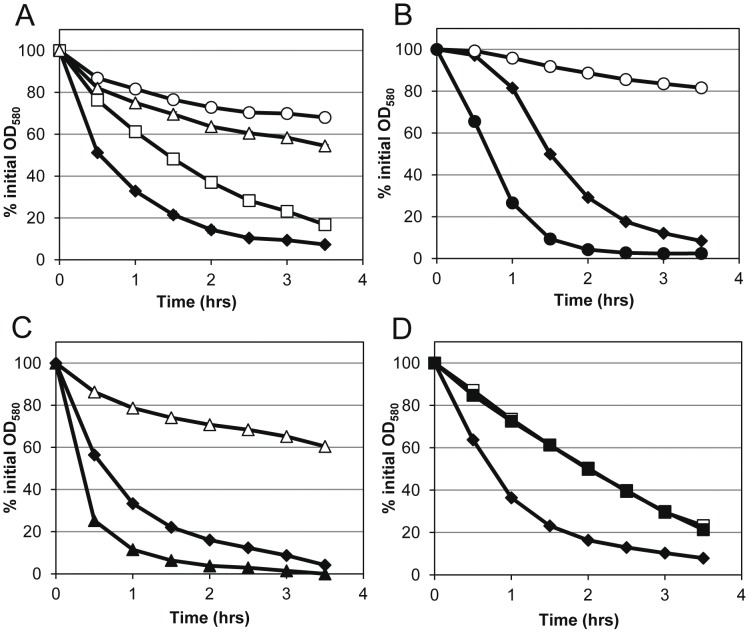
Autolysis of atl mutants.Triton X-100 induced autolysis of mid-exponential phase cultures grown in TSB with 1 M glucose at a 1∶10 media to flask volume ratio. A) comparison of UAMS-1 (solid diamonds), Δatl mutant (empty circles), ΔatlAM mutant (empty triangles), and ΔatlGL mutant (empty squares). B) UAMS-1 (solid diamonds), Δatl mutant (empty circles), and mutant with atl complement plasmid pJB141 (solid circles). C) UAMS-1 (solid diamonds), ΔatlAM mutant (empty triangles), and mutant with atlAM complement plasmid pJB111 (solid triangles). D) UAMS-1 (solid diamonds), ΔatlGL mutant (empty squares), and mutant with atlGL complement plasmid pJB135 (solid squares). B–D) UAMS-1 and mutants contain vector alone plasmid pJB128. Data represent the mean (n = 3 for panel A, n = 2 for B–D) with standard error (bars are smaller than symbols).